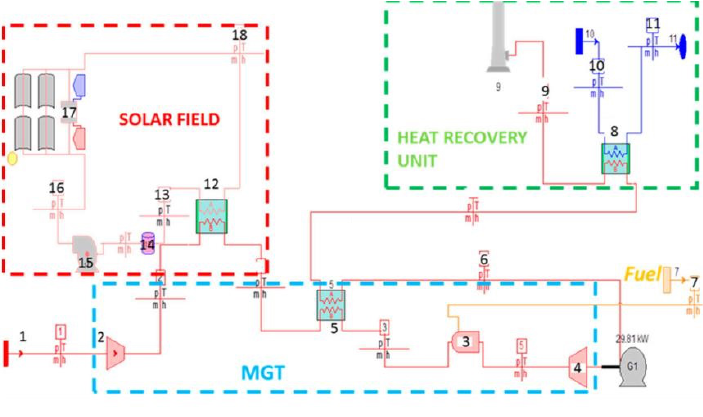
Figure 9. Hybrid MGT-solar power plant [102].